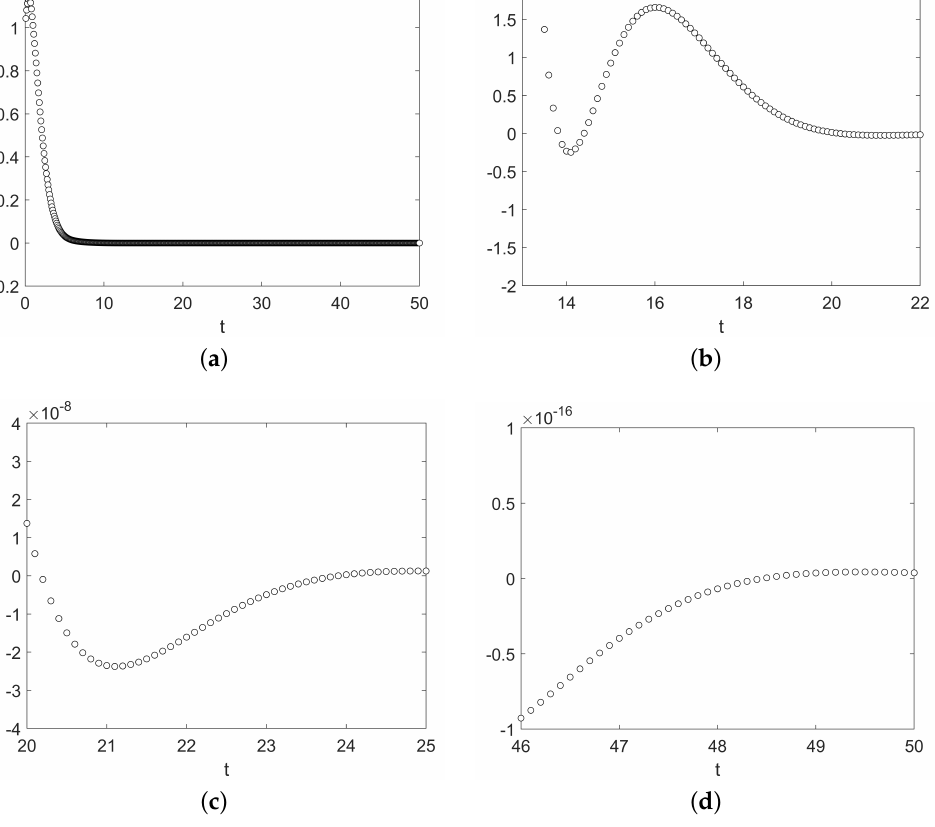
Figure 5. Numerical solution for the first component of Example 1 and zoom-views in different intervals. ( a ) t ∈ [ 0,50 ] . ( b ) t ∈ [ 13,22 ] . ( c ) t ∈ [ 20,25 ] . ( d ) t ∈ [ 46,50 ]